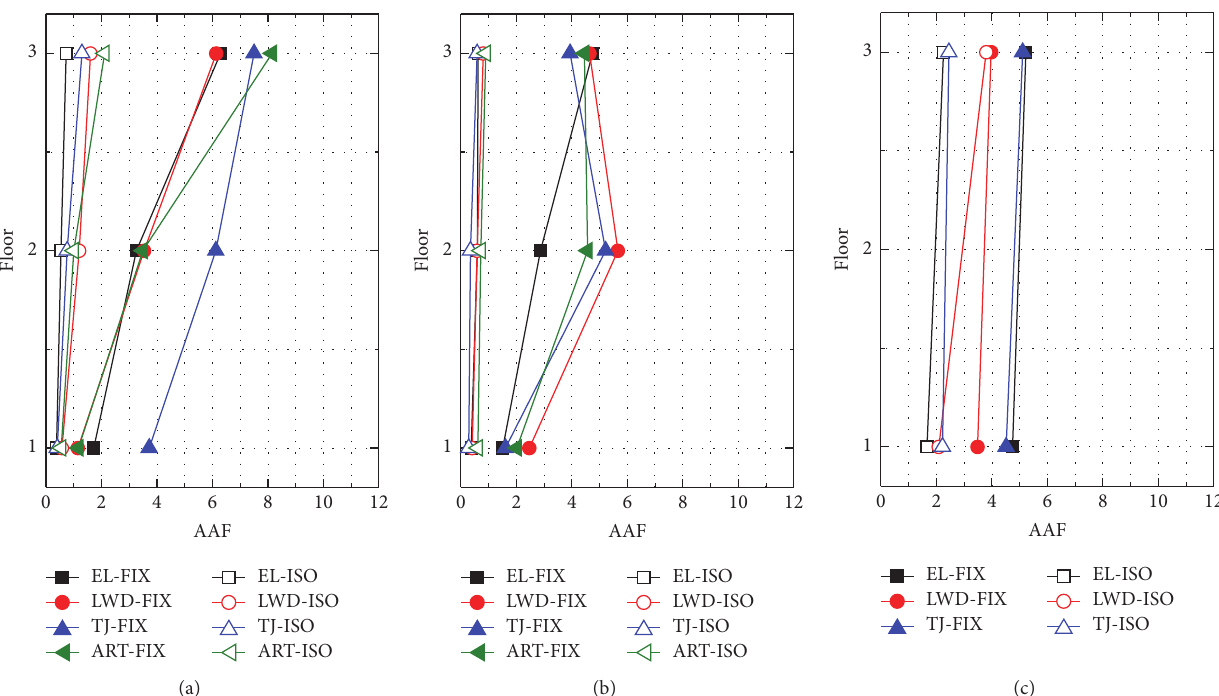
Figure 20: Comparisons on profiles of “Treasures fill the house” AAFs for the isolated and fixed structure under major earthquake: (a) direction x ; (b) direction y ; and (c) direction z .